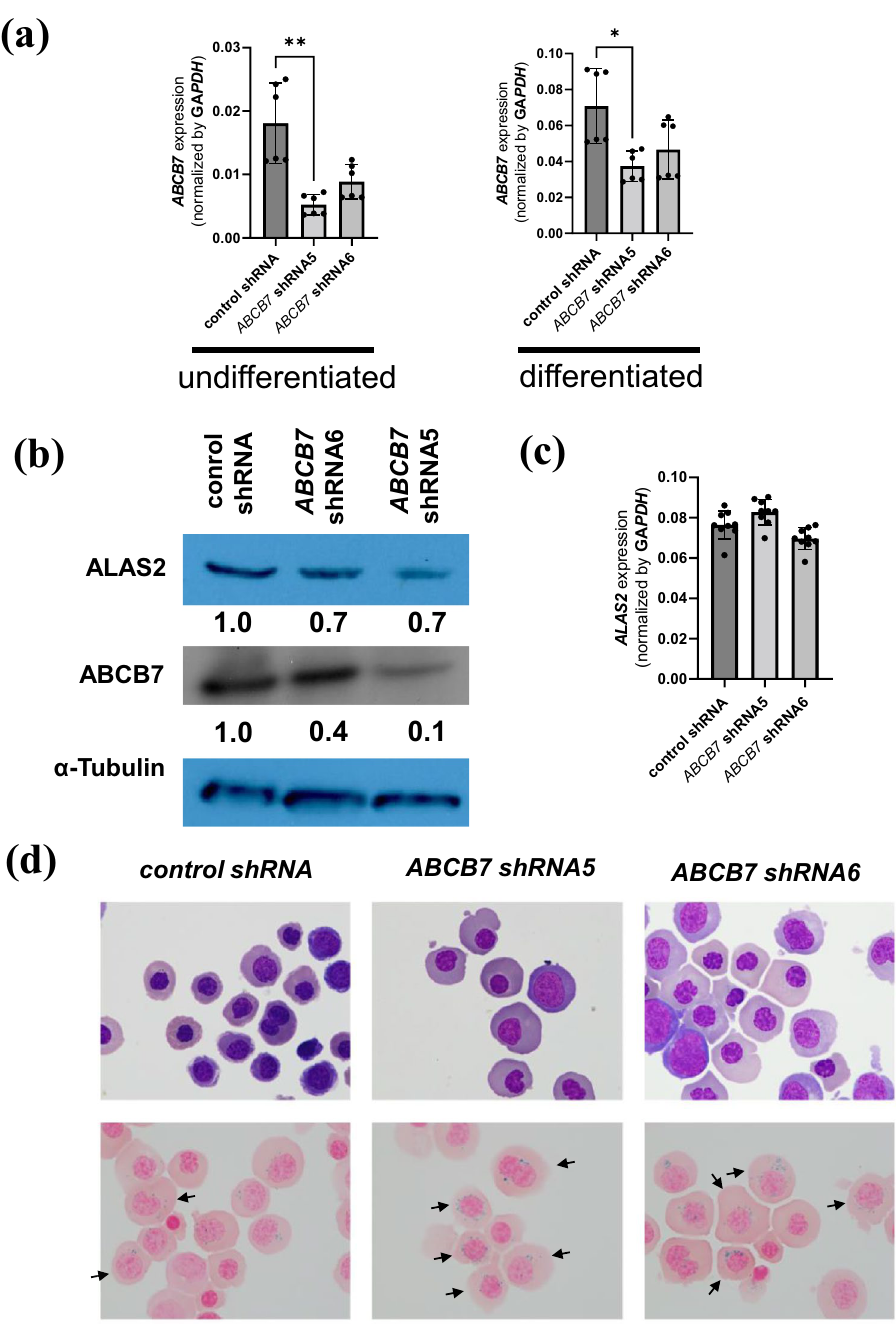
Figure 5. Analysis of ABCB7 -knockdown HUDEP-2 cells. ( a ) Expression levels of ABCB7 by quantitative RT-PCR (results shown as mean ± SD and dot plots) in undifferentiated and differentiated ABCB7 -knockdown HUDEP-2 cells; * p < 0.05, ** p < 0.01. ( b ) Western blot analysis for ALAS2, ABCB7 and α-Tubulin in undifferentiated ABCB7 -knockdown HUDEP-2 cells. Relative expression levels of ALAS2 and ABCB7 in ABCB7 -knockdown HUDEP-2 cells in comparison to control shRNA-transduced HUDEP-2 cells described under the picture. α-Tubulin was used as a loading control. The image of each protein was cropped from the different fields of the film. The original film is presented in Supplementary Fig. S23-24 online. ( c ) Expression levels of ALAS2 by quantitative RT-PCR (results shown as mean ± SD and dot plots) in undifferentiated ABCB7 -knockdown HUDEP-2 cells. ( d ) Representative micrograph of cytospin slides for differentiated ABCB7 -knockdown HUDEP-2 cells. The upper photographs show slides stained with May–Grünwald–Giemsa stain, and the lower ones represent those stained with Prussian blue. Ring sideroblasts are indicated by black arrows. Control, shRNA5, and shRNA6 represent HUDEP-2 cells transduced with control shRNA, HUDEP-2 cells transduced with ABCB7 shRNA clone 5, and HUDEP-2 cells transduced with ABCB7 shRNA clone 6,